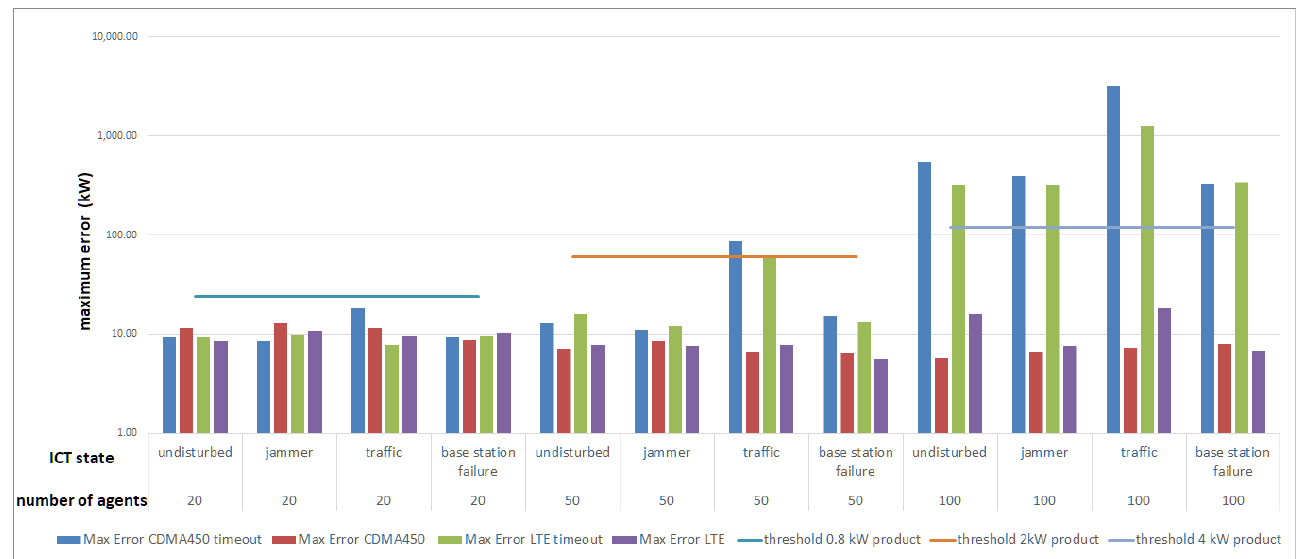
Figure 9. Maximum deviation of the solution to the target schedule for both communication technologies with and without negotiation time-out. From left to right: the scaled numbers of agents in the VPP for the different ICT scenarios. The accepted deviation from the respective products serve as